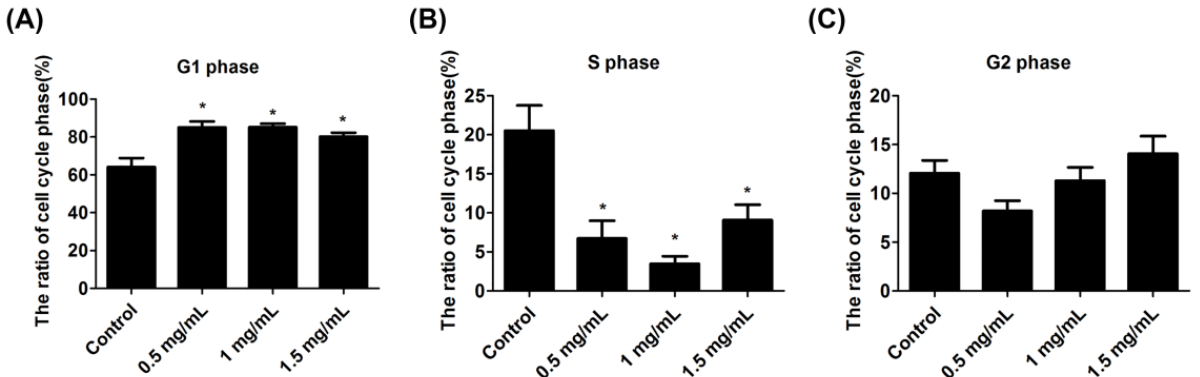
Figure 3. Cell cycle analysis of tendon cells. Tendon cells were either left untreated or were treated with 0.5 mg/mL, 1.0 mg/mL, or 1.5 mg/mL lidocaine for 24 h. The cell cycle analysis was performed by flow cytometry. The result for the G1 phase is presented in ( A ). The result for the S phase is presented in ( B ). The result for the G2 phase is presented in ( C ). Data are presented as the means ± standard errors of the mean of three independent experiments. * p <